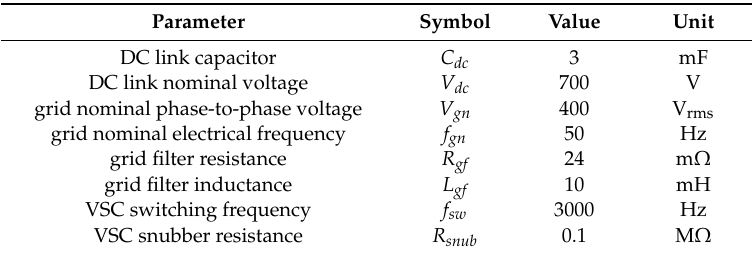
Table 3. DC link, VSCs and grid